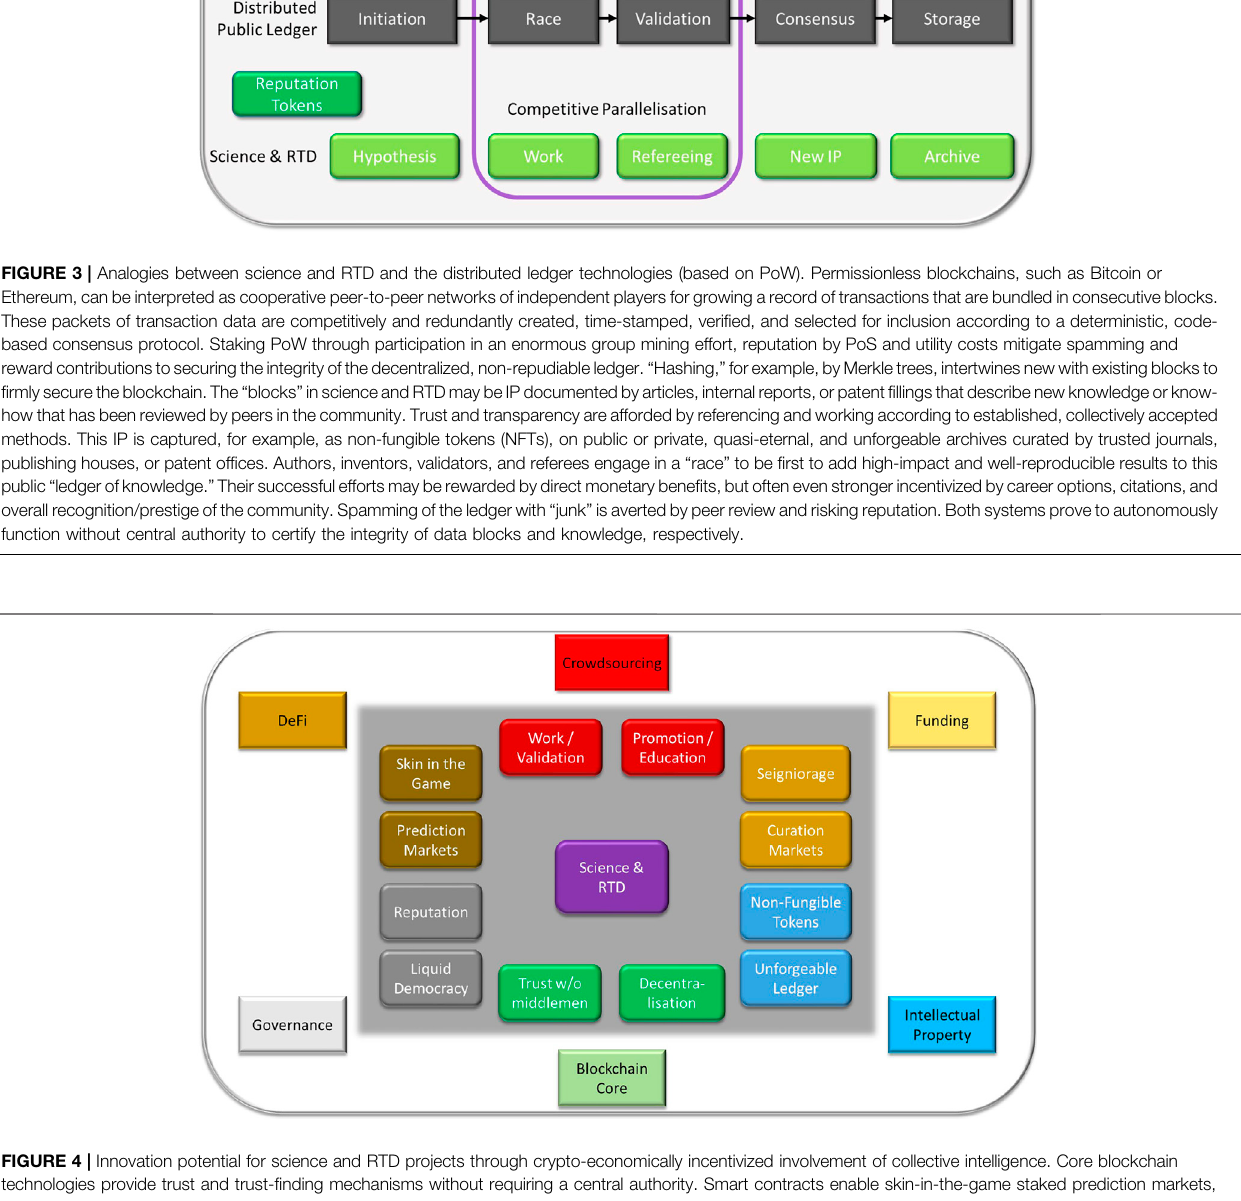
Frontiers in Blockchain |